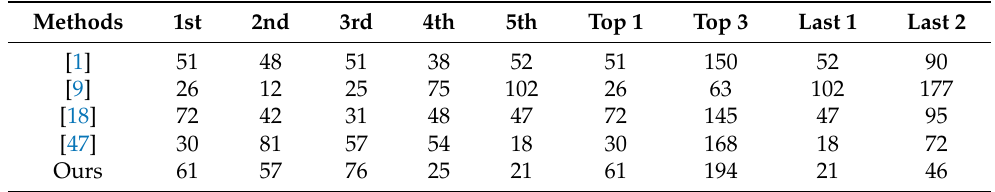
Table 7. Ranking results of user study. Fields 1, 2, 3, 4, 5 in the table represent the statistics of the number of times that each algorithm is ranked 1st, 2nd, 3rd, 4th, and 5th, respectively. Methods